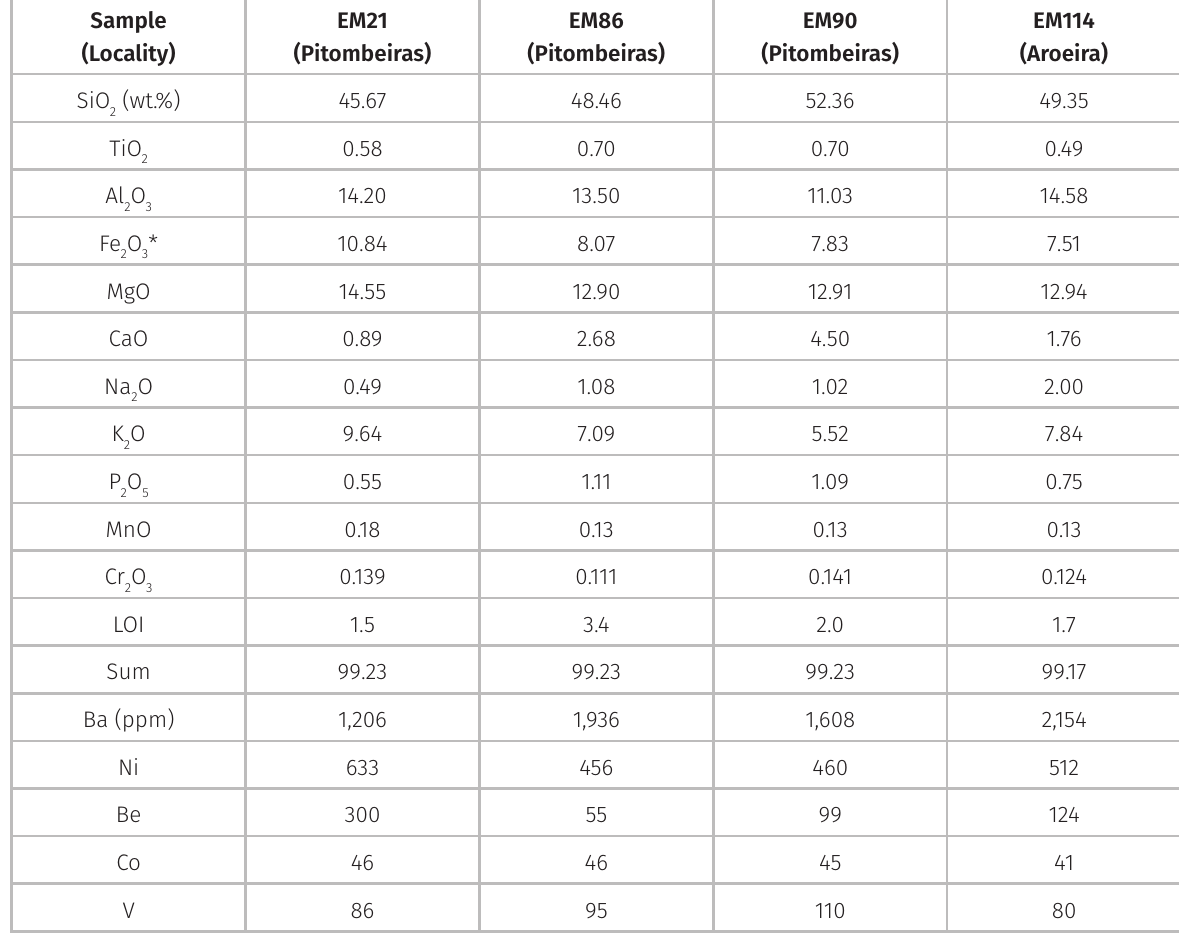
Table I. Whole-rock geochemistry for phlogopite schists of Paraná emerald deposit.